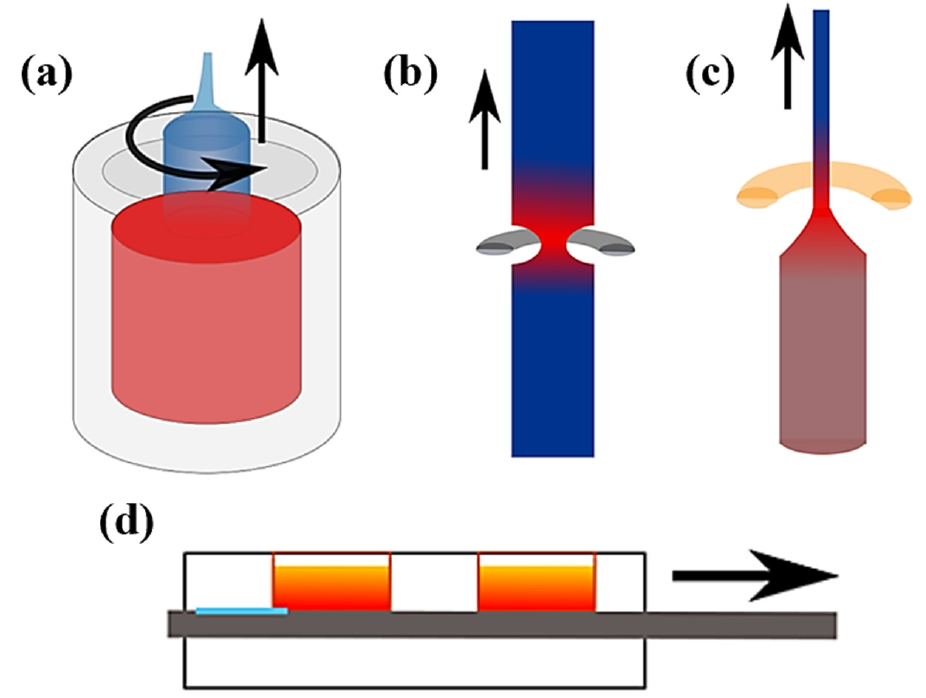
Figure 2. Material fabrication techniques. (Reprinted with permission from ref. [51]. Copyright 2021 Ursula J. Gibson et al.): ( a ) CZ growth, ( b ) FZ growth, ( c ) LHPG, and ( d ) LPE.